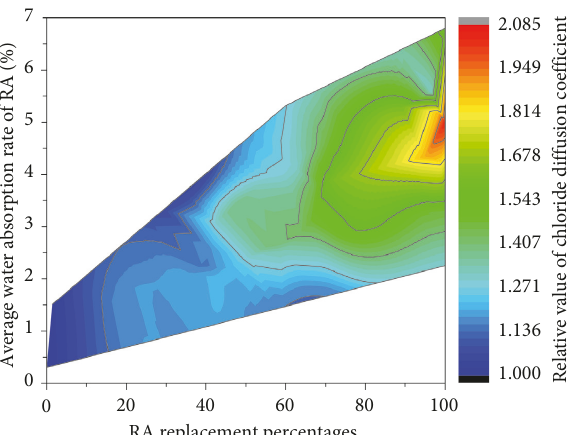
Figure 6: Correlation between the relative chloride diffusion coefficient of RAC, average water absorption rate, and replacement per- centages of RA.